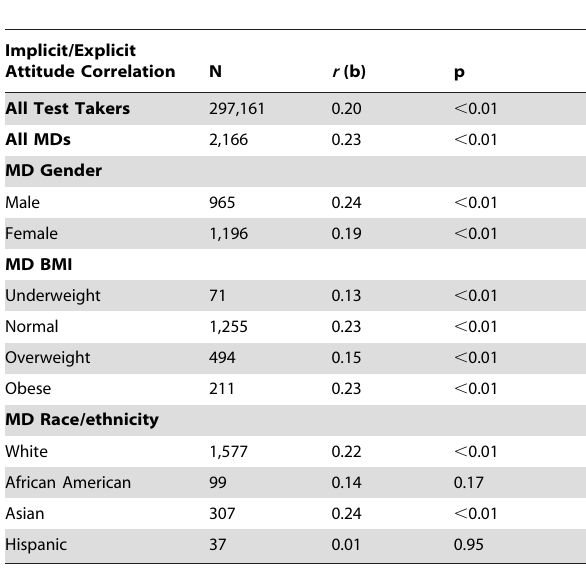
Table 6. Inter-correlation Between Implicit and Explicit Weight Attitude